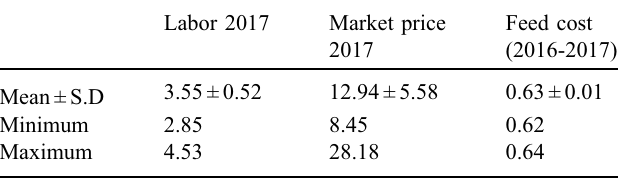
Table 4. Basic statistics for the parameters considered for the sensitivity analysis. Sources of information: for labor, minimal wage, the Mexican Revenue Service (SAT, sat. gob. mx, 2017); for market price the questionnaire applied to fi shermen and clients; for feed cost the historical price variation from Pedregal Silver Cup